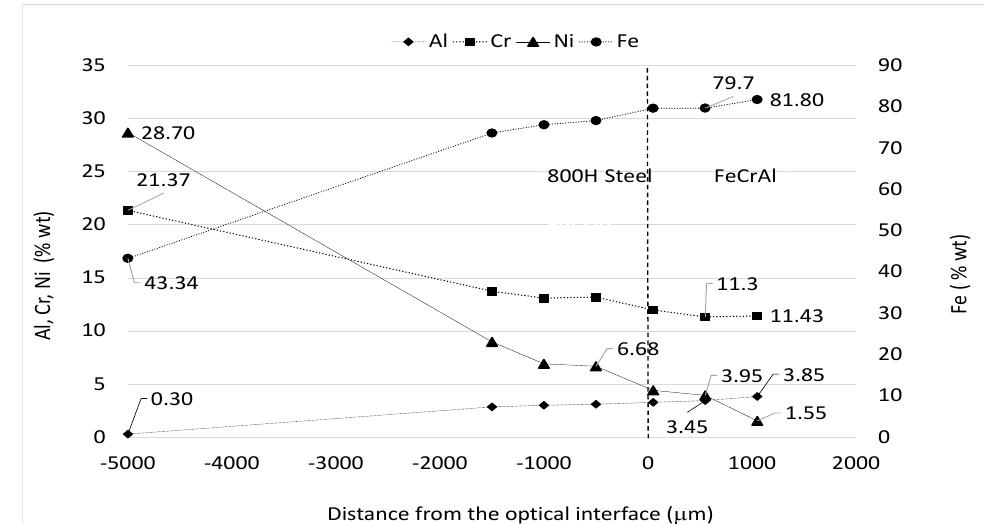
Figure 7. EDS chemical element diffusion across the optical interface (dashed line at point 0) of 800H steel coated with Kanthal Nextower 1.